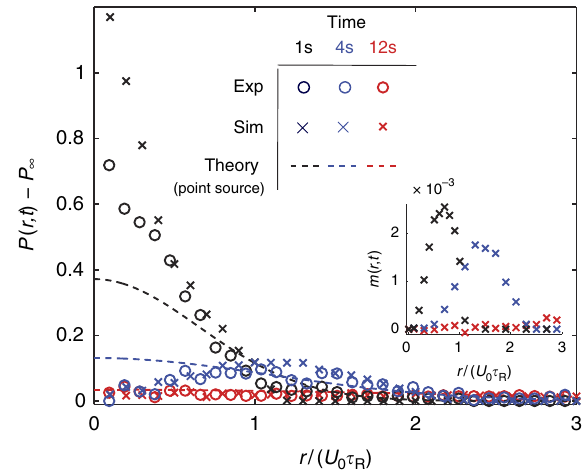
Figure 4 | Evolution of active crystal ‘explosion’. Transient probability density of 2 m m swimmers as they explode from the crystal, drawn at three representative times as described in the text. Dashed curves are the analytical theory of diffusion of a point source, equation 2 (for 1s and 4s, drawn as a reference for comparison), and the circles and crosses are the experiment and Brownian dynamics simulation, respectively. Inset shows the polar order of the swimmers m ( r , t ) as the peaks spread outward. We average over four independent explosion measurements for a duration of 30s after release; each run consists of E 150 spreading